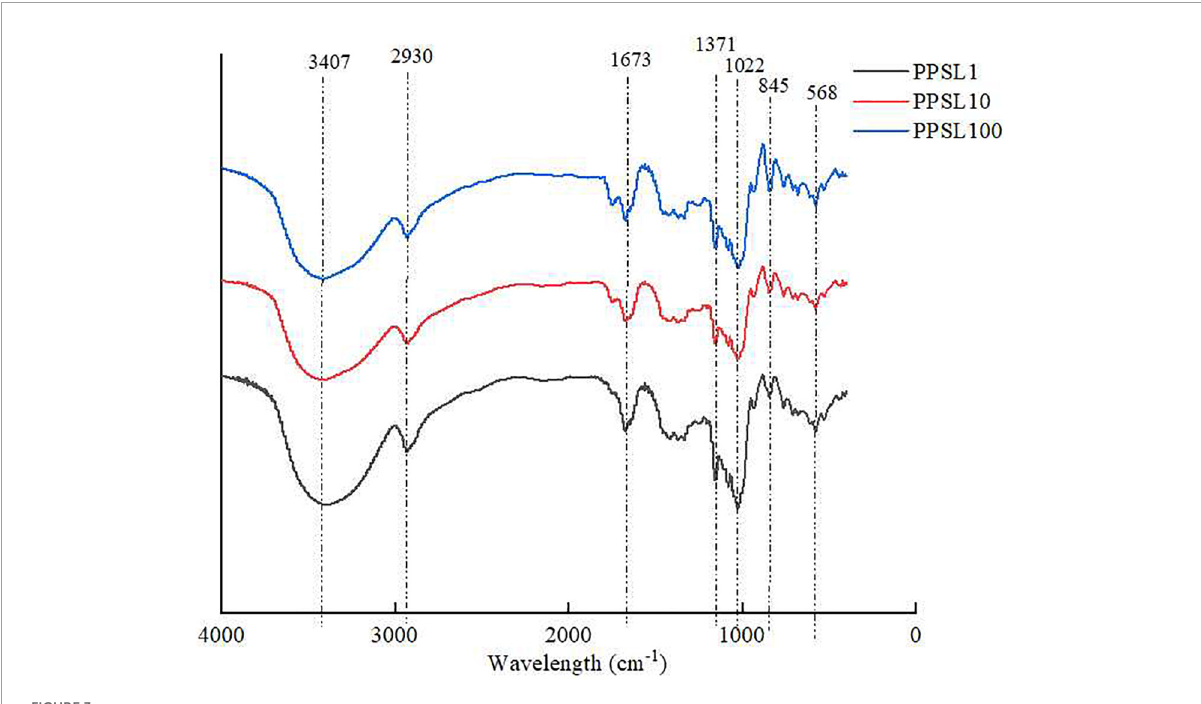
FIGURE3 FT-IR spectrum of PPSL1, PPSL10, and PPSL100.